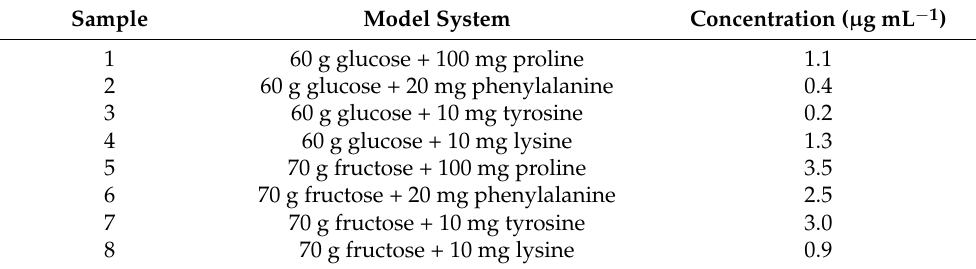
Table 1. Aqueous model systems of sugars and amino acids analyzed by UPLC-Q-ToF-MS and the concentration of 4(5)-MEI after their thermal